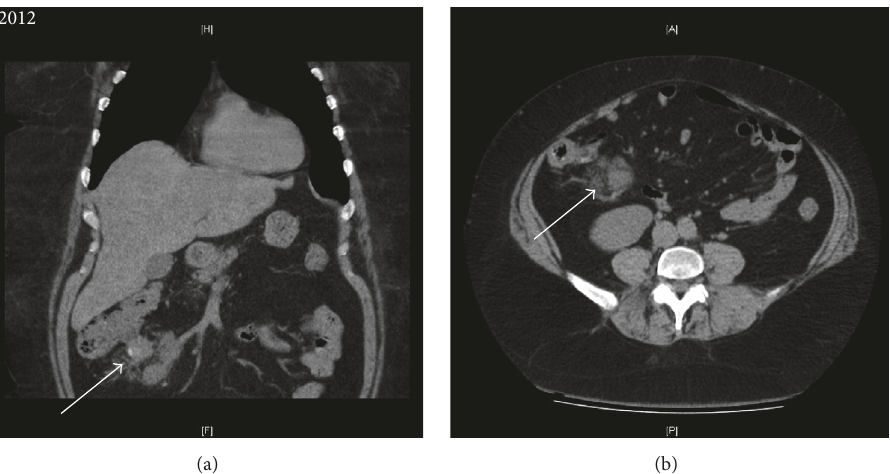
Figure 1: 2012 Coronal enhanced (a) and axial enhanced (b) CT showing hypovascular solid mass (white arrow) in the mesentery of the right lower quadrant.